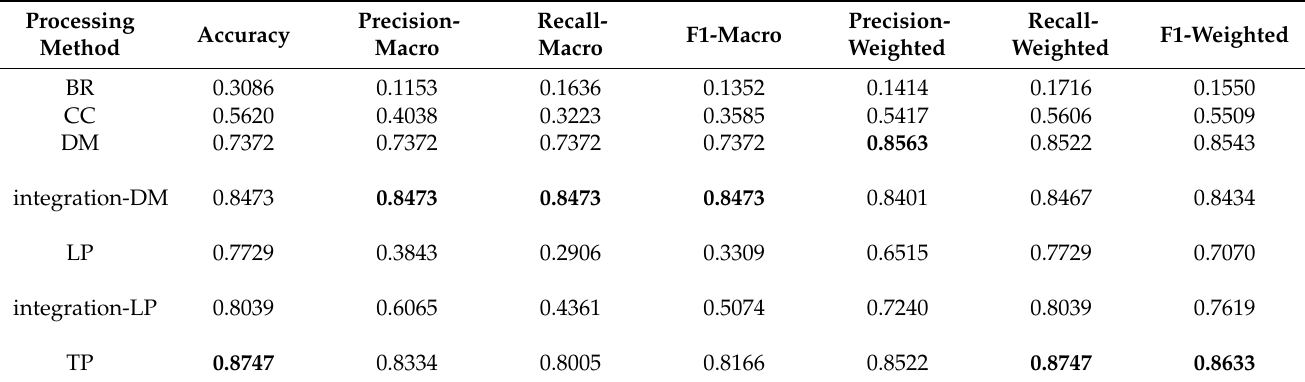
Table 10. Evaluation index values of various processing